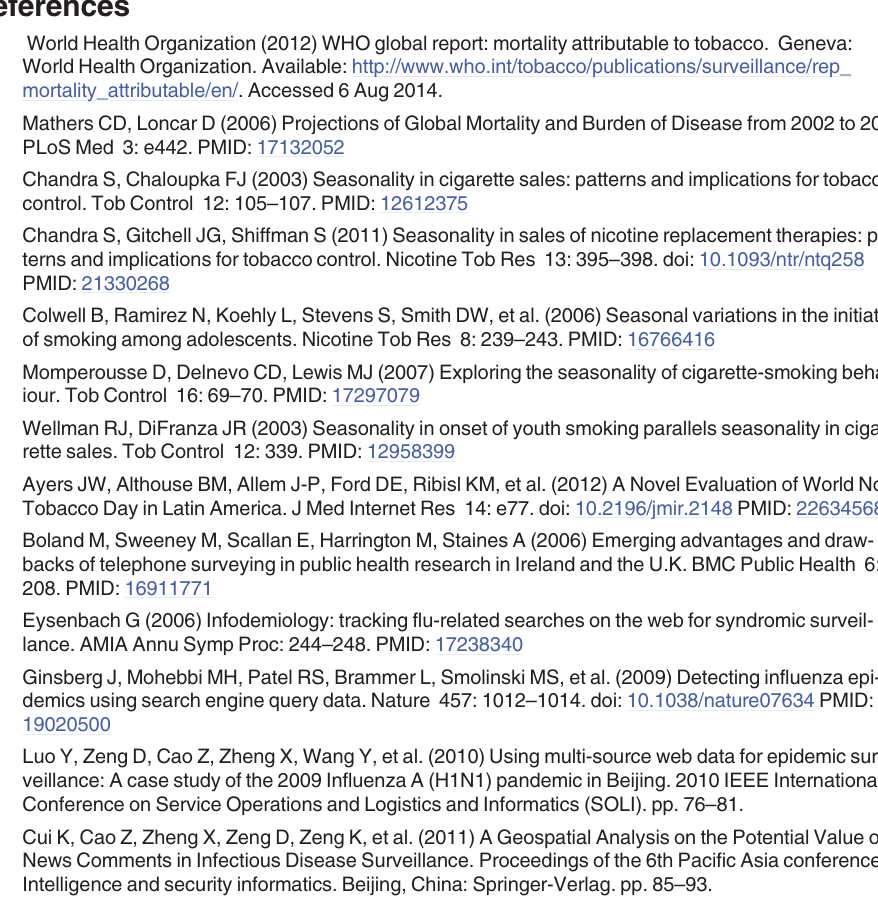
S3 Table. Stationarity test of seasonal components of tobacco-related search trends. S4 Table. Stationarity test of seasonal components of search trends regarding lung